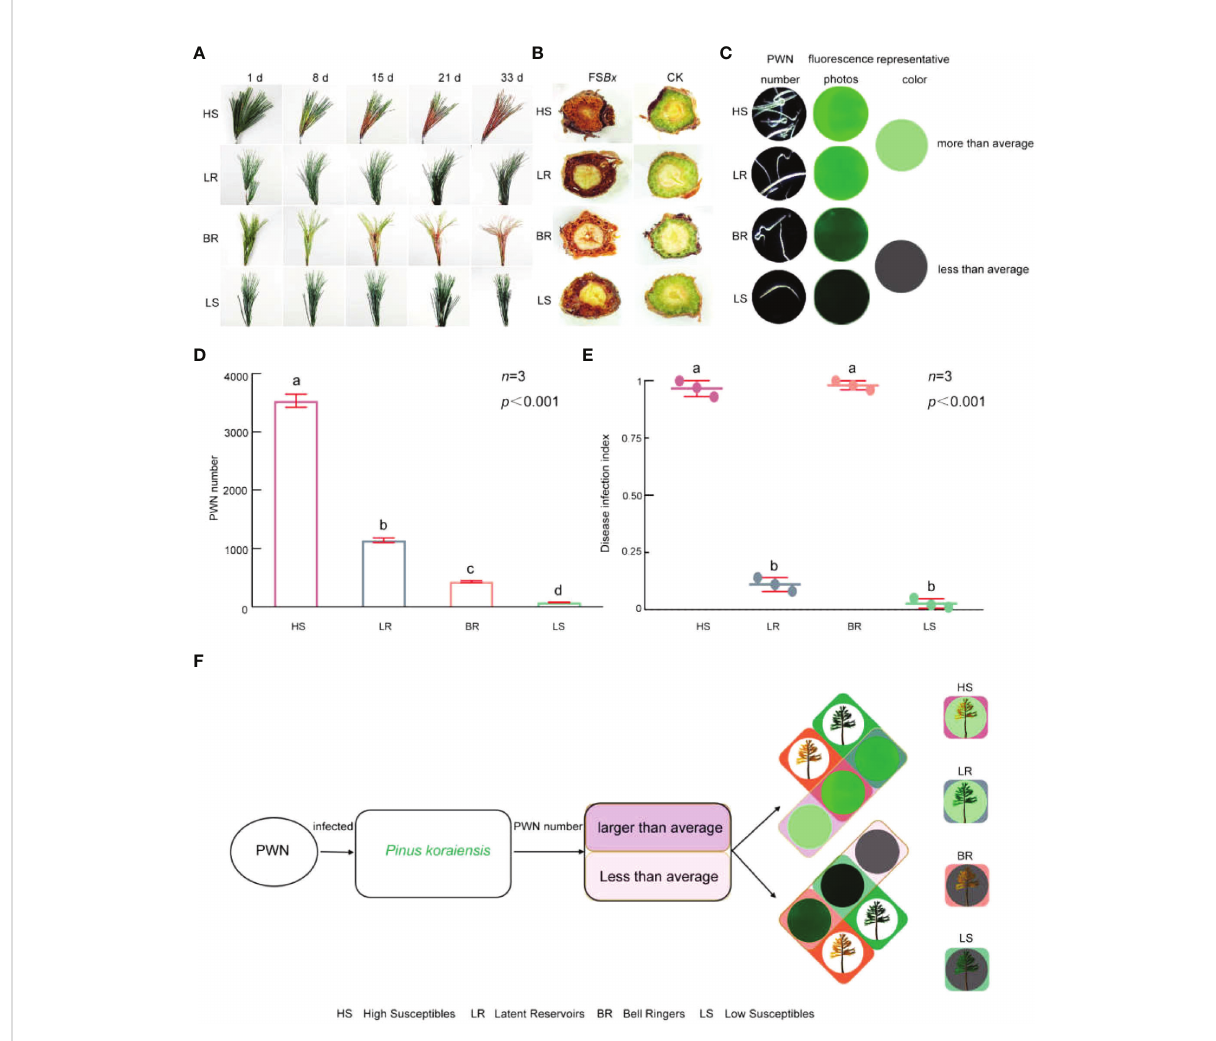
FIGURE 2 Characteristics of 4 types of P. koraiensis infected by PWN. (A) Symptoms of 4 types of P. koraiensis inoculated with PWN. (B) Transverse sections of PWN-infected branches at 33 dpi. (C) PWNs as seen via fl uorescence microscopy images at 33 dpi. (When the number of PWNs exceeded 1,000, the green fl uorescence was very obvious; thus, green was selected as the representative color of PWN-rich individuals, and gray represents individuals with fewer PWNs.) (D) Number of PWNs isolated from the 4 types of P. koraiensis . (E) Disease infection index of the 4 types of P. koraiensis . (F) Classi fi cation of the 4 types of P. koraiensis . Data in (D, E) were analyzed by one-way ANOVA followed by Tukey ’ s posthoc test, with different letters indicating statistically signi fi cant differences at 95% con fi dence. The data in the fi gures are means ± SE ( n =3). Letter a: the maximum average number marked with the letter a Letter b: The maximum average is compared with the following averages. Where the difference is not signi fi cant, the letter a is marked until a signi fi cant difference is marked with the letter b Letter labeling followed by analogy. Where there is an identically marked letter, the difference is not signi fi cant; where there are different marked letters, the difference is signi fi